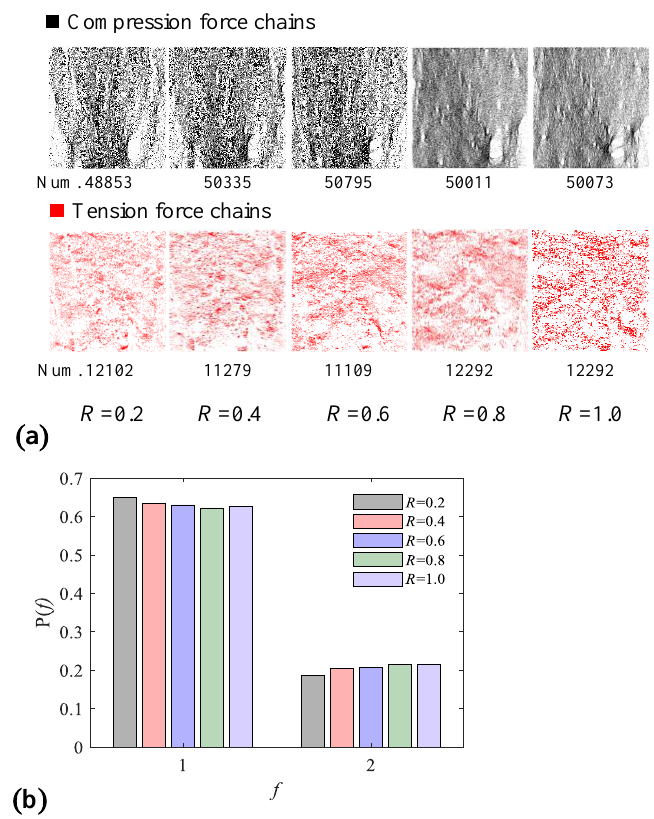
Figure 9. Force-chains strength properties. ( a ) Distribution of tension chains and compression chains; ( b ) strength probability of force—chains. Figure 9b divides the contact force into two parts: the weak contact force interval